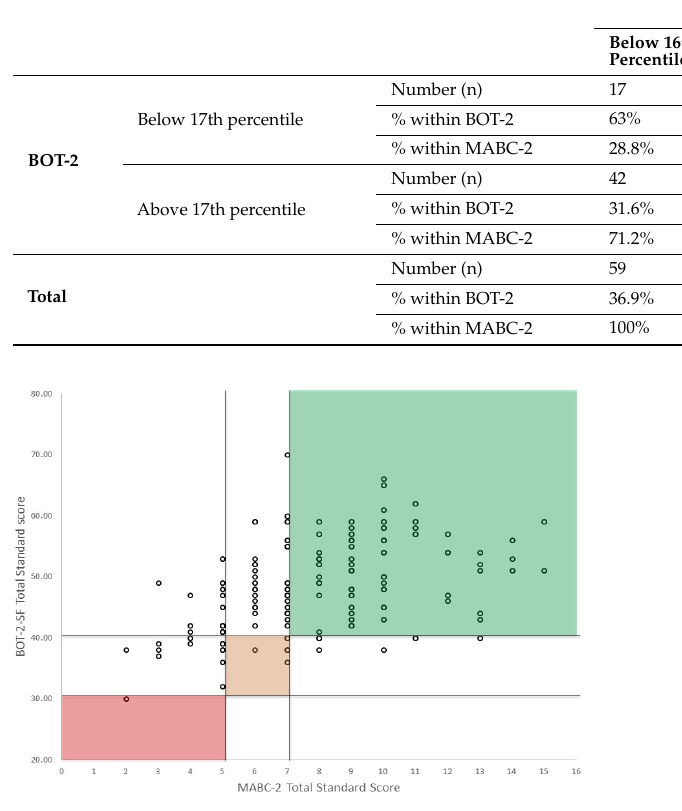
Figure 2. Classification agreement between MABC-2 and BOT-2 (Green: no movement difficulty, Amber: at risk of having movement difficulty; Red: significant movement difficulty). Colored areas show children that had the same classification of the two tests. Please note the children on the left side of the graph (0–5 standard scores on the MABC-2: significant motor difficulty) who score in the normal range (>40) on the BOT-2.